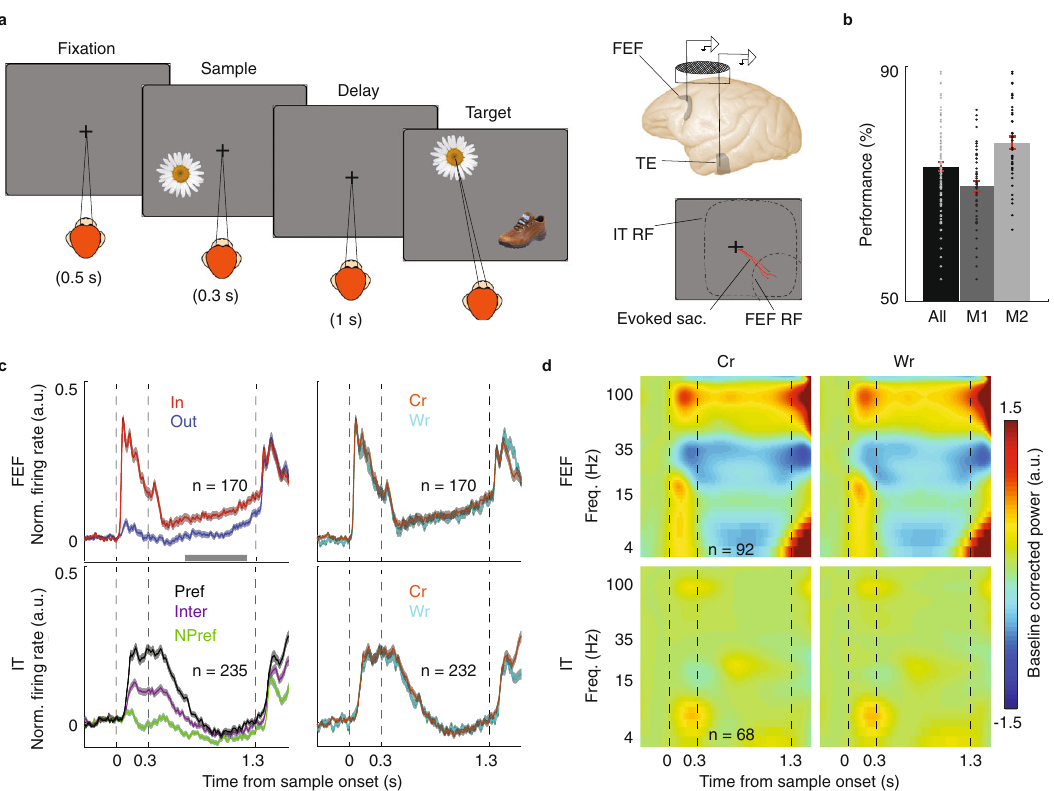
Fig. 1 Firing rate and LFP power in IT and FEF were largely unrelated to DMS performance. a Schematic of the object DMS task. Left, After the monkey fi xated, a sample stimulus appeared either in or opposite the FEF neuron ’ s RF location. The sample stimulus disappeared, and the monkey maintained fi xation throughout a blank delay period. The same stimulus appeared again (target) along with a distracter and the monkey needed to saccade to the target stimulus to receive a reward. Right, Recordings were made simultaneously from the FEF and the TE part of IT in a single recording chamber. The FEF RF was estimated based on microstimulation-evoked saccades (red lines). The IT RF generally encompassed both sample locations. b Performance of individual monkeys (M1, M2) and their average (All) on the DMS task; points show mean performance in individual sessions; bars show mean across sessions ± SEM in red ( n = 51 sessions in M1 and 41 sessions in M2). c Normalized fi ring rates of FEF (top) and IT populations (bottom) across the course of the DMS task, when the sample was inside (red) or outside (blue) of the neurons ’ RFs, and when the sample object was preferred (black), non-preferred (green), or intermediate (violet) are shown on the left. Right, normalized fi ring rate of the FEF (top) and IT populations (bottom) for correct vs. wrong trials. Data (mean ± SEM) were smoothed within a window of 10 ms. d Time-frequency maps of normalized LFP spectral power for FEF (top, n = 92 LFP sites) and IT (bottom, n = 68 LFP sites) for correct (left) and wrong (right)